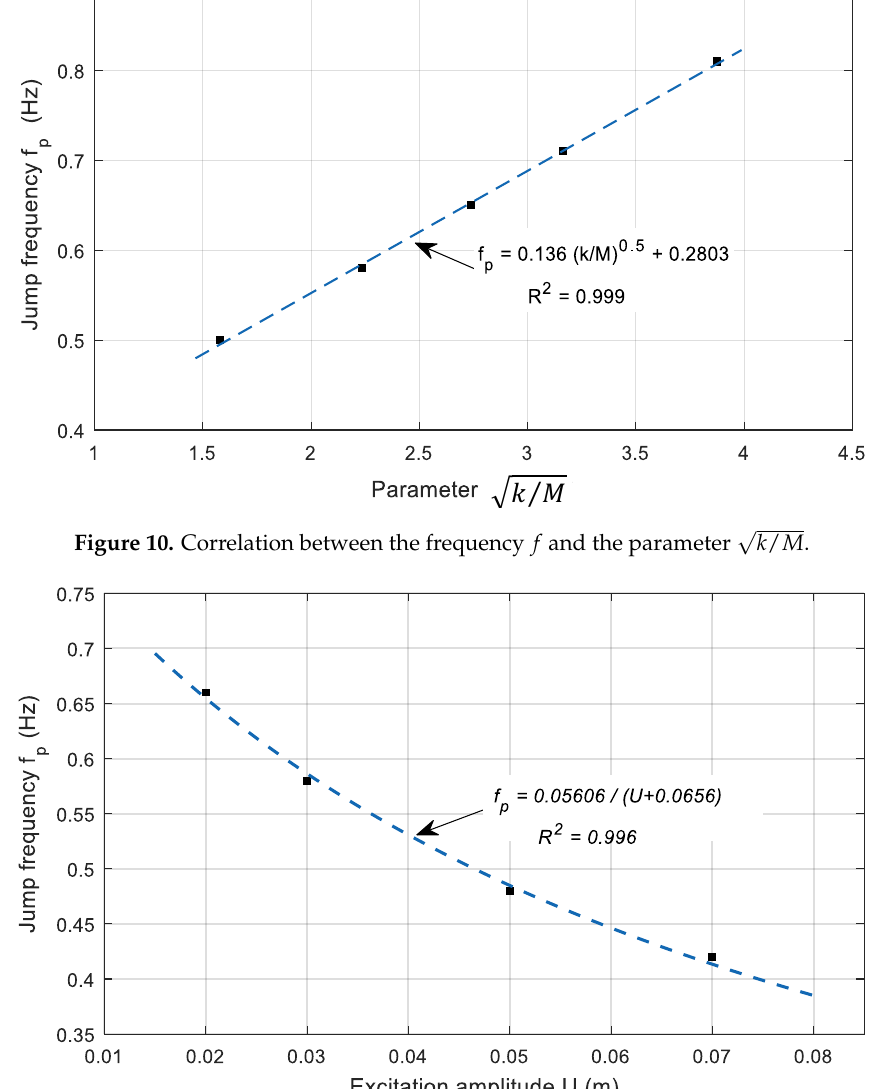
Figure 11. Correlation between the frequency 𝑓 and the amplitude 𝑈 .